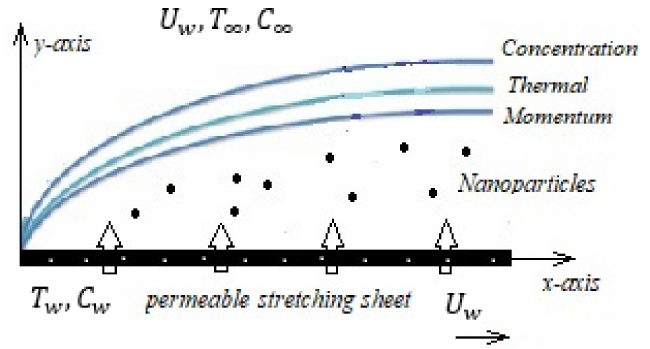
Figure 1. Geometry of the